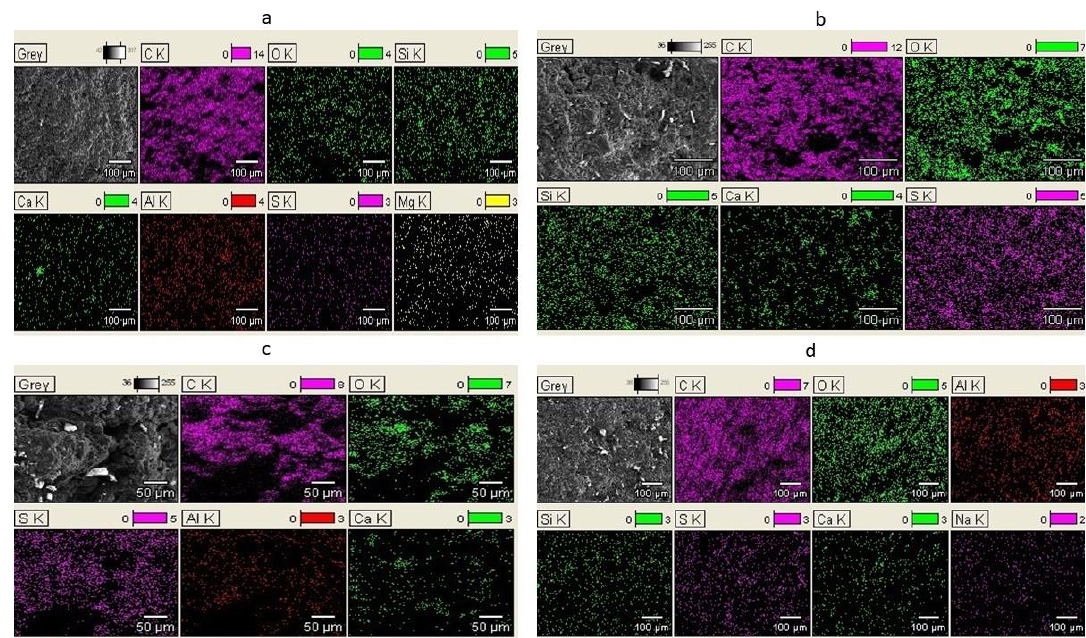
Figure 5. SEM-EDX analysis of activated carbon (fresh and used) in the deSO x and deNO x adsorber: ( a ) AC-P; ( b ) used AC-P (1); ( c ) used AC-P (2) and ( d ) used AC-P (3).